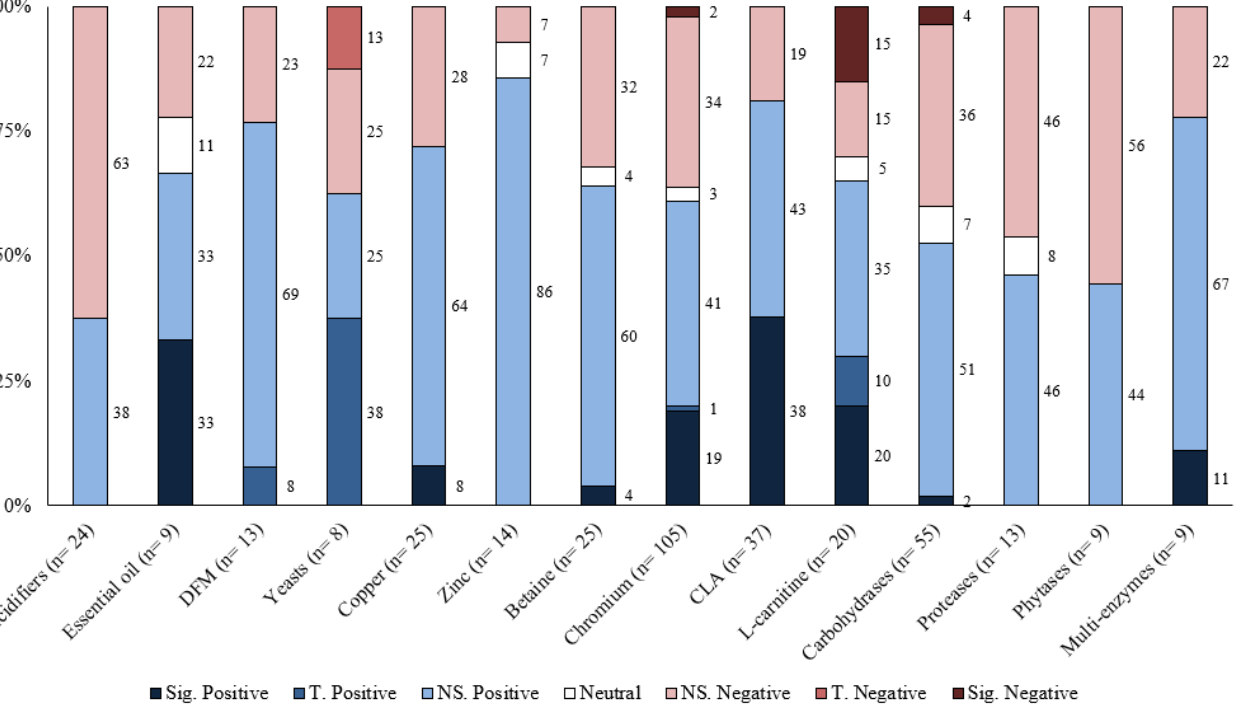
Figure 4. The distribution of results for various feed additives on percentage lean by significance level and direction. The comparison was significant (Sig.) if p ≤ 0.05, had a tendency (T.) if 0.05 < p ≤ 0.10, and was non-significant (NS.) if p > 0.10.